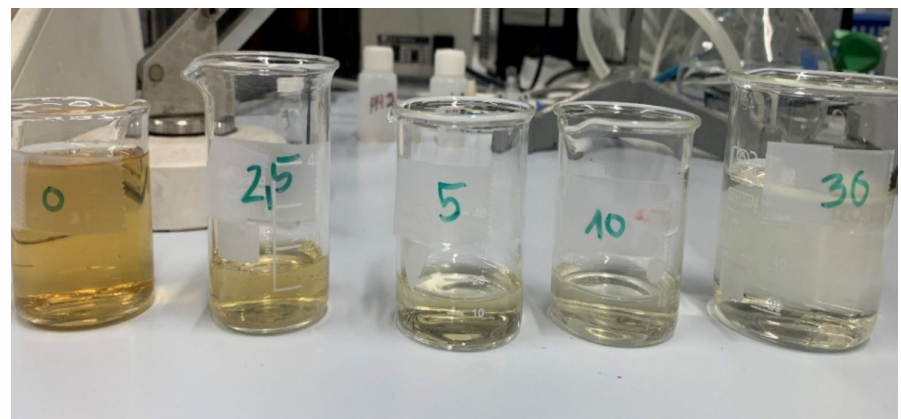
Figure 2. Reduction in color due to the time of ozonation: 0, 2.5, 5, 10, and 30 min.